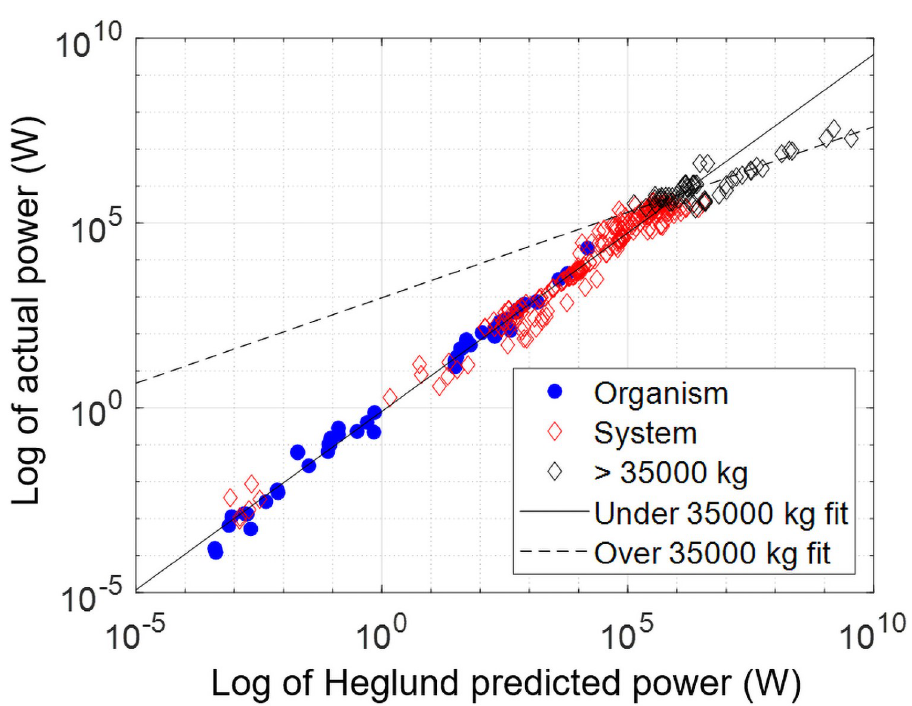
Fig 2. Log of actual power versus predicted power for organisms and artificial systems. Below 35,000 kg, both organisms and artificial systems fit well the line with slope 0.946 ± 0.125 and intercept -0.0830 ± 1.20. There is no statistically significant difference in slopes (p-value = 0.357) and intercepts (p-value = 0.985). For systems over 35,000 kg, however, the curve fit is distinctly different.